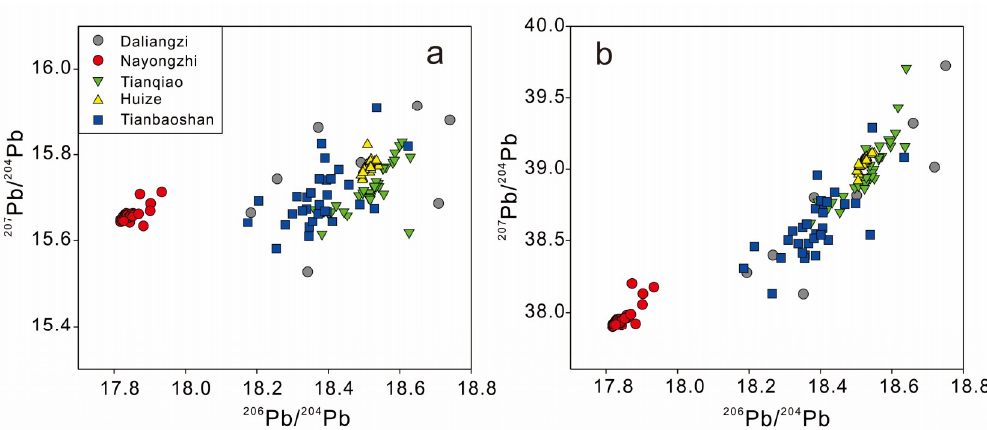
Figure 14. Correlative diagrams of 206 Pb/ 204 Pb VS. 207 Pb/ 204 Pb ( a ) and 206 Pb/ 204 Pb VS. 208 Pb/ 204 Pb ( b ) for the Tianbaoshan, Daliangzi, Huize, Tianqiao and Nayongzhi deposit in S-Y-G Zn-Pb metallogenic province. Note: plots are based on data from Jin et al. [17,24], Bao et al. [26], Liu and Lin [36], Zheng et al. [39,63], Chen et al. [62], Wang. [64], Zhang et al. [65], Fu [66], Wang et al. [67] and Zhou et al.